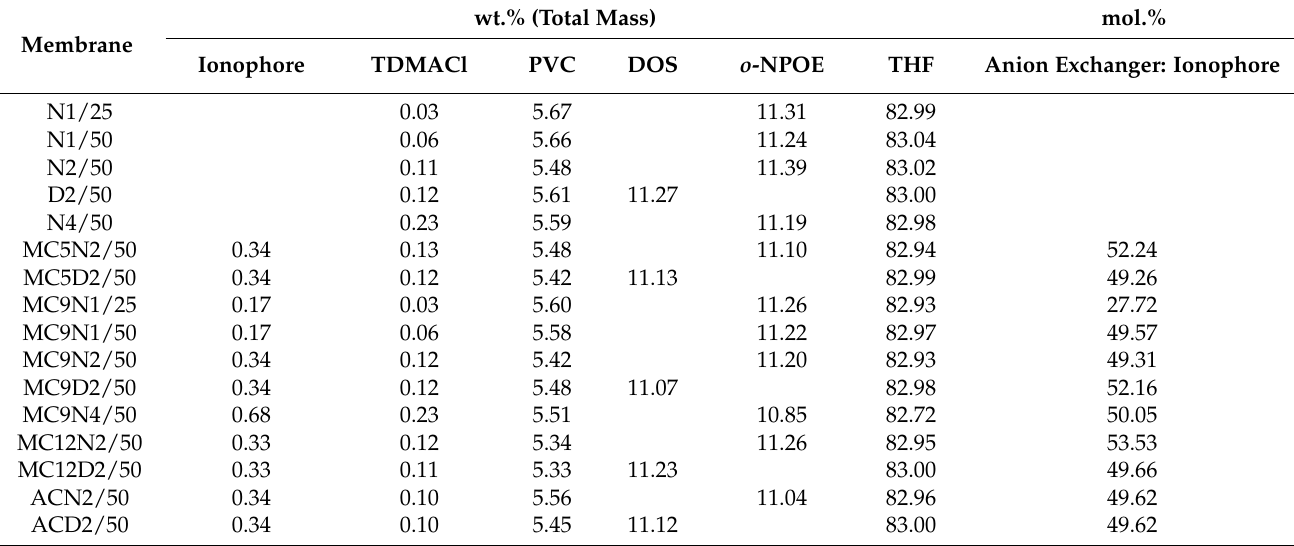
Table 1. Compositions of the membrane cocktails. Membranes are labeled according to the format WXY / Z , where W is the ionophore (absent for controls), X is the plasticizer (D for DOS and N for o -NPOE), Y is the intended mass percentage (dry mass) of the ionophore, and Z is the intended ratio (mol.%) of anion exchanger to ionophore. See Figure 1 for ionophores. wt.% (Total Mass)